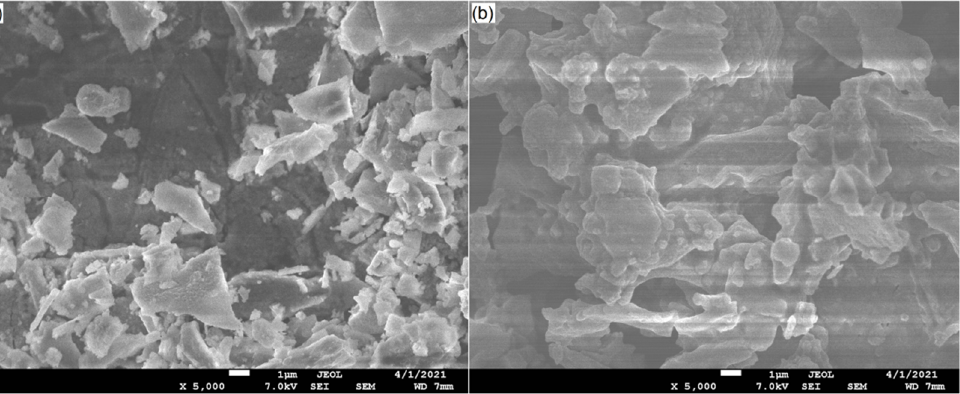
Figure 6. Scanning electron micrographs of LDRLE ( a ) and LDRLE-zinc chelate ( b ) with magnification of 5000× and a scale bar of 1 μ m.